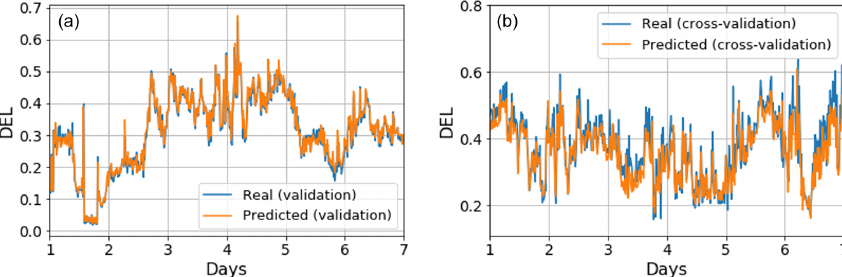
Figure 11. (a) Time series of DEL for 7d of the validation dataset (real – blue; predicted – orange). (b) As in panel (a) but for the cross- validation dataset (different turbine from training).